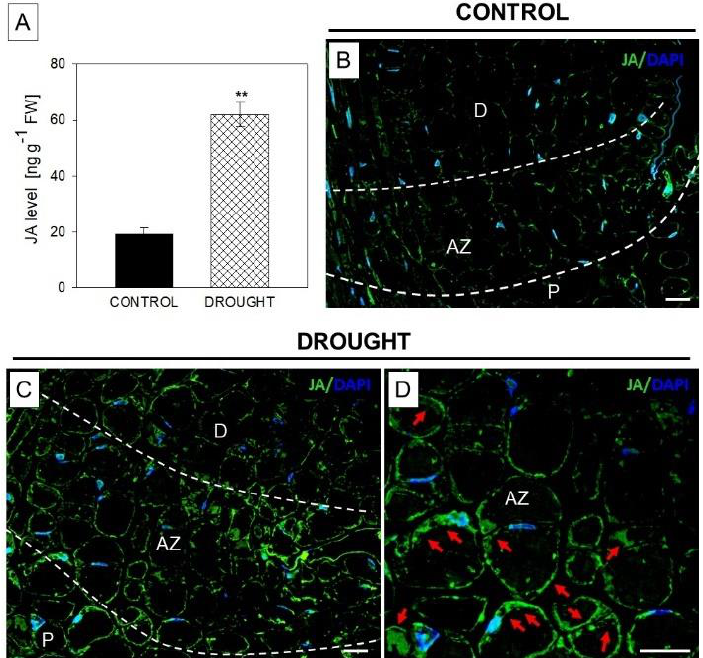
Figure 4. Drought upregulates the level of jasmonic acid (JA) in the abscission zone (AZ) of yellow lupine flowers. AZ fragments were collected for these analyses from 48 day-old plants subjected to drought (25% water holding capacity, WHC) or lupines cultivated in the soil of optimal moisture (70% WHC, control). Details in the Material and Methods section. The level of JA was examined using GC-MS ( A ). A significant difference is ** p < 0.01. Immunolocalization of JA in the AZ of control ( B ) or stressed ( C , D ) plants. Green fluorescence is related to JA localization (indicated by red arrows), whereas blue color corresponds to DAPI-stained nuclei. AZ area is marked by white dotted lines ( B , C ). ( D ) image is magnified AZ area presented on C. Abbreviations: AZ—abscission zone; D—distal region of AZ; P—proximal region of AZ. Bars = 40 µM.